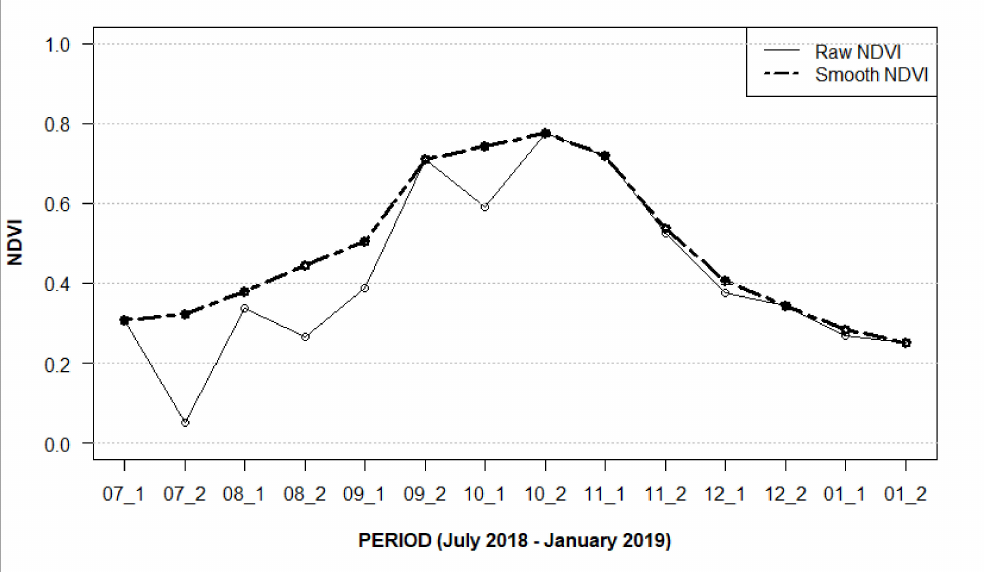
Figure 6. Raw and smoothed 2018 NDVI temporal dynamic for a pixel (Lat. − 15.5669, Lon. 12.6794) of a paddy rice plot in Samiron